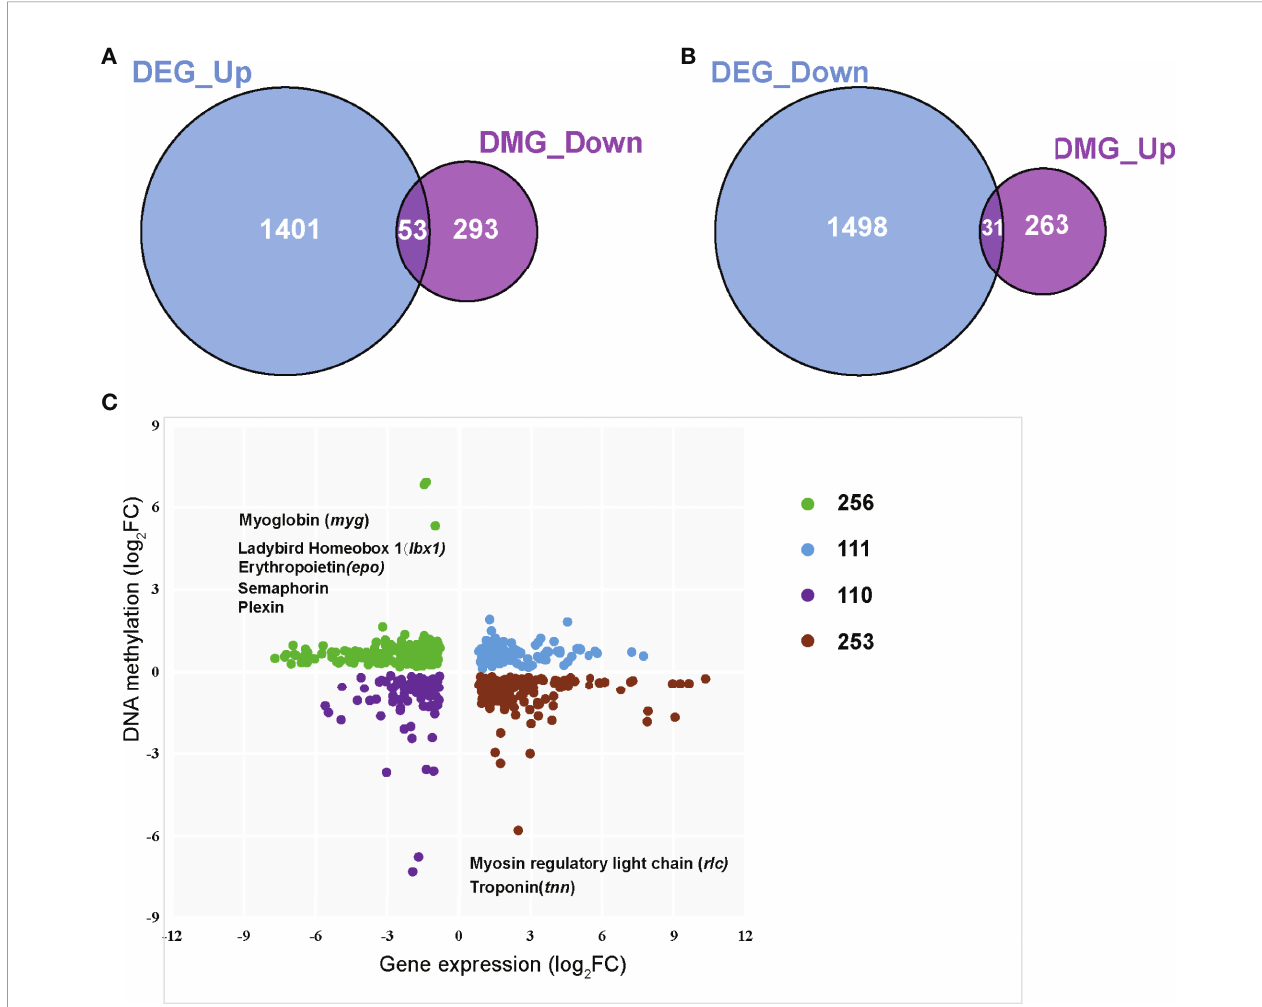
FIGURE 3 | Integrated analysis of the genome-wide DNA methylation and gene expression pro fi les between slow- and fast-twitch muscles. (A) Venn diagram of overlapped hypo DMGs in promoters and upregulated DEGs in SM. (B) Venn diagram of overlapped hyper DMGs in promoters and downregulated DEGs in SM. (C) . Integrated analysis of DNA methylation levels and gene expression levels. The vertical axis represents the DNA methylation level, and the horizontal axis shows the gene expression. FCs (fold changes) indicates the DNA methylation or gene expression of SM relative to that of